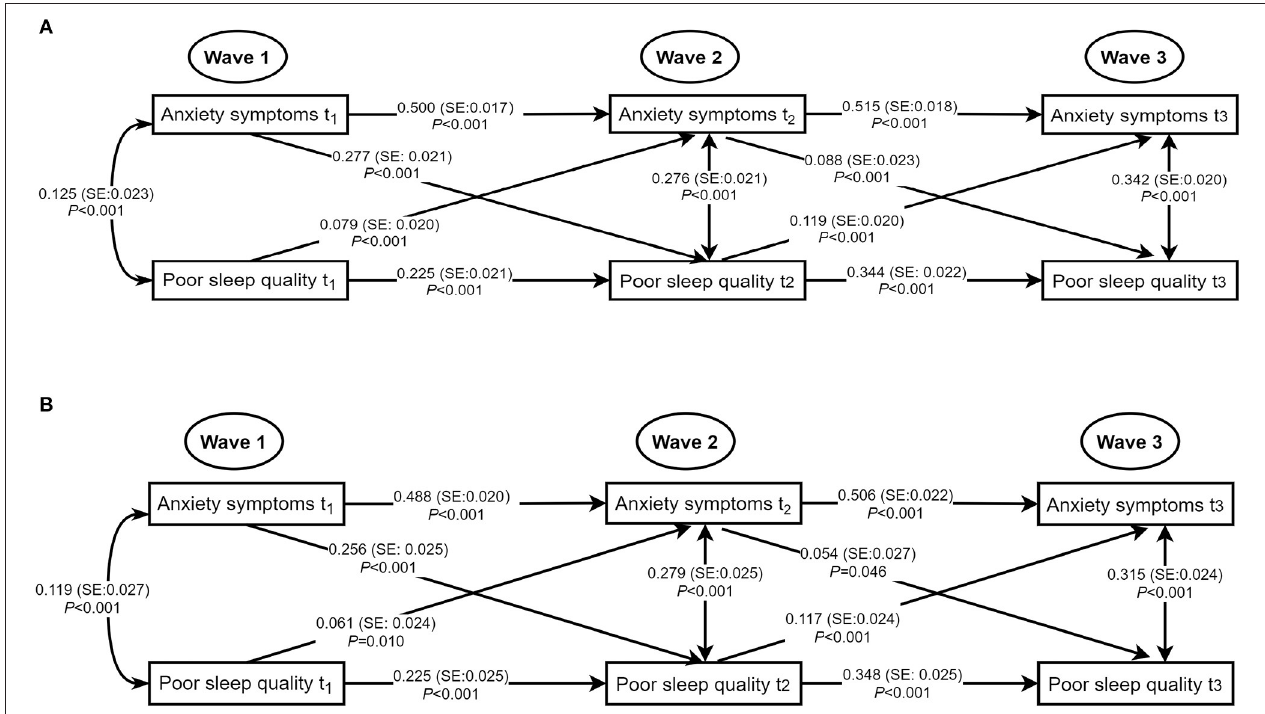
FIGURE 1 | Concurrent and cross-lagged associations between poor sleep quality and anxiety symptoms. (A) Unadjusted models. (B) Models adjusting for age, sex, living arrangement, family relations, student-teacher relations, ever smoking, and ever drinking; for clarity of presentation, the standardized coefficients of the control variables were not displayed in the model but were included in the analyses. SE, standard error; the solid line meant the standardized coefficient was statistically